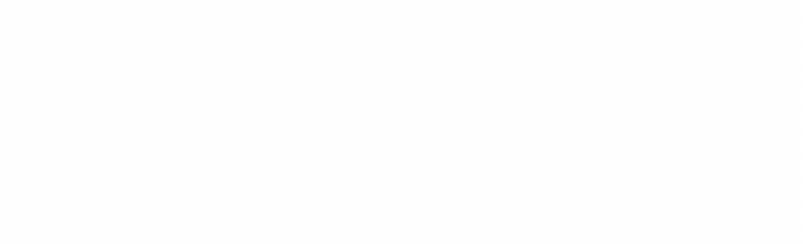
FIGURE 4a Distribution of price changes, very high market price